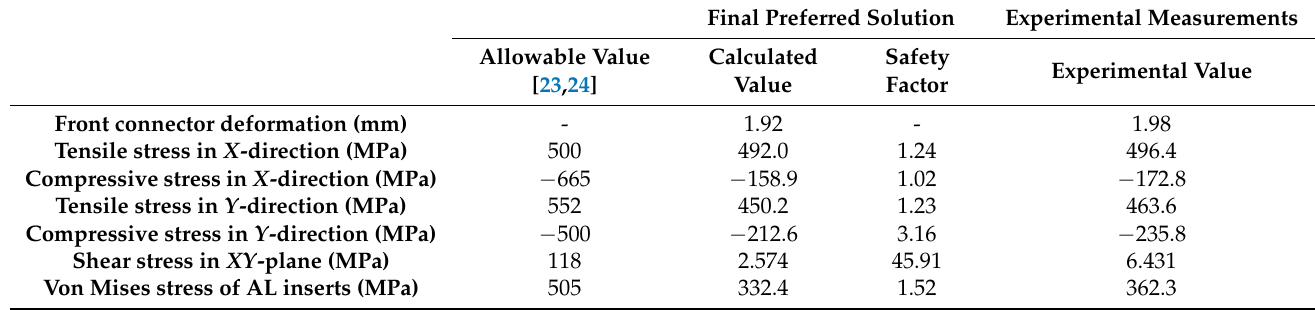
Figure 5. Deformation and maximum shear stress diagrams of the front connector: ( a ) deformation